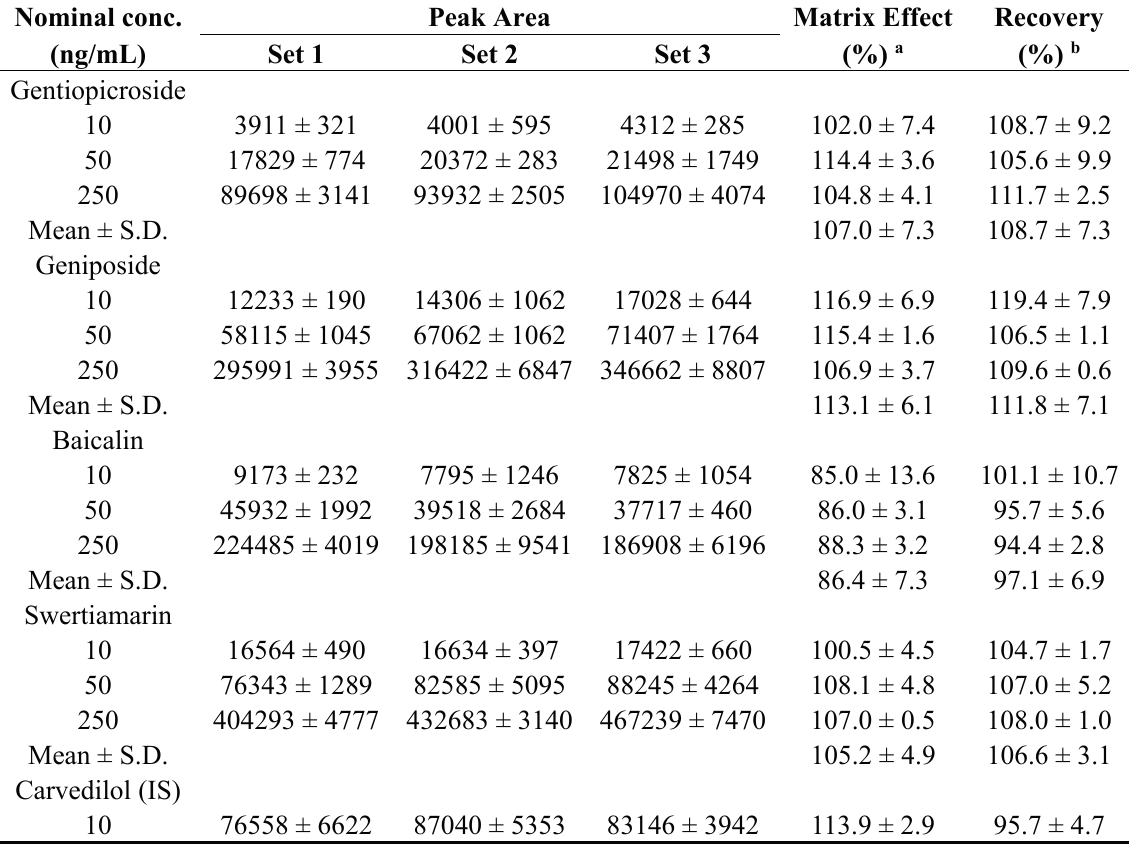
Table 3. Matrix effect and extraction recovery of the four components and internal standard in rat plasma after sample